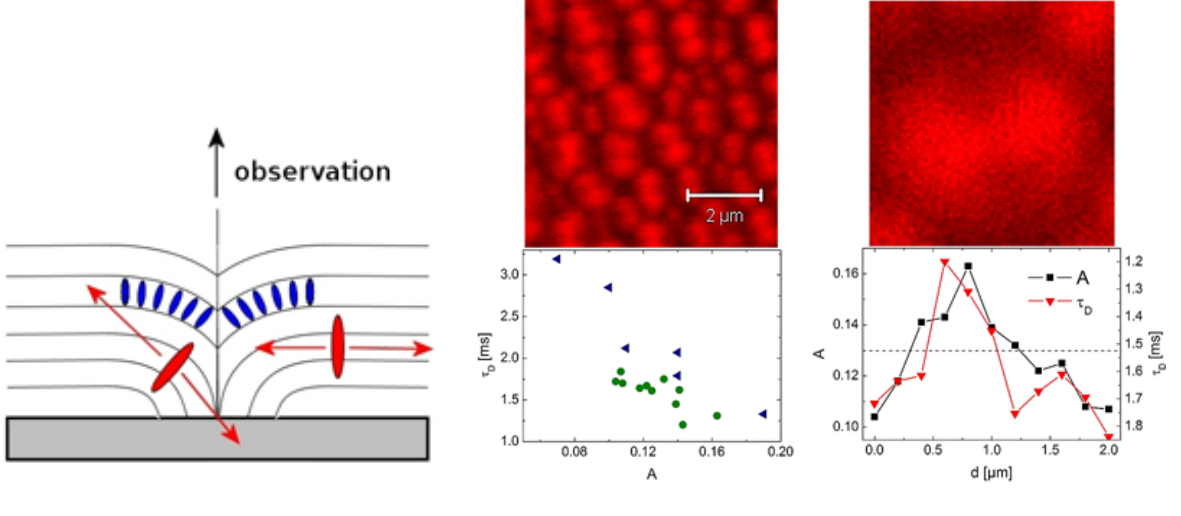
Figure 3. ( Left ) Schematic presentation of a focal conic domain (FCD) with incorporated o-PDI. Preferred directions of emission of o-PDI molecules in different areas of FCD are indicated by arrows. ( Middle and Right ) Correlation between the amplitude A of the autocorrelation function and the characteristic time τ for o-PDI. Bottom middle: τ as a D D function of the corresponding amplitude A for two independent measurements. The absolute values of A depend on the arbitrarily chosen scanning line across a typical sample (top middle). Bottom right: amplitude A and τ as a function of the spatial position d along D an arbitrarily chosen scan across the sample (through a FCD) with steps of length 200 nm. Lines are for eye guide. The broken line denotes half of the maximum intensity. On top right an image section of 2 microns size is shown for comparison. Note that the graphs on top show fluorescence emission from a different sample with higher dye concentration than the data shown below. Images and captions taken from [36], Copyright 2011 by The Royal Society of Chemistry, with permission